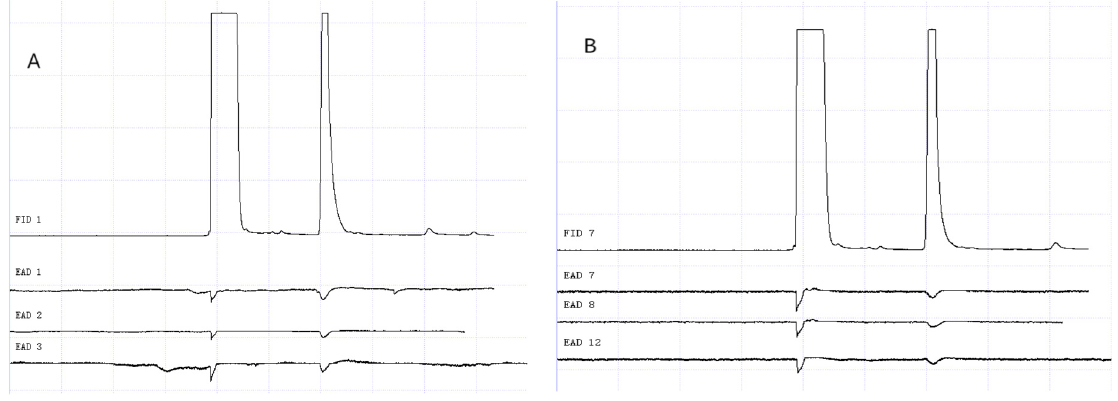
Figure 15. GC-EAD responses of 7-day-old W. magnifica to methylheptenone. ( A ) Male. ( B ) Female.